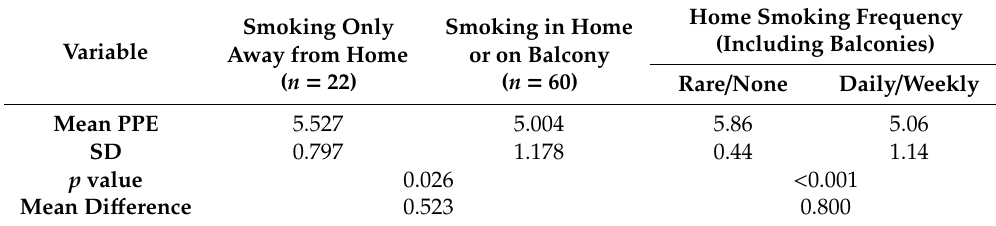
Figure 2. Parental perceptions of exposure according to parental home smoking location. Table 2. Di ff erences in PPE by home smoking